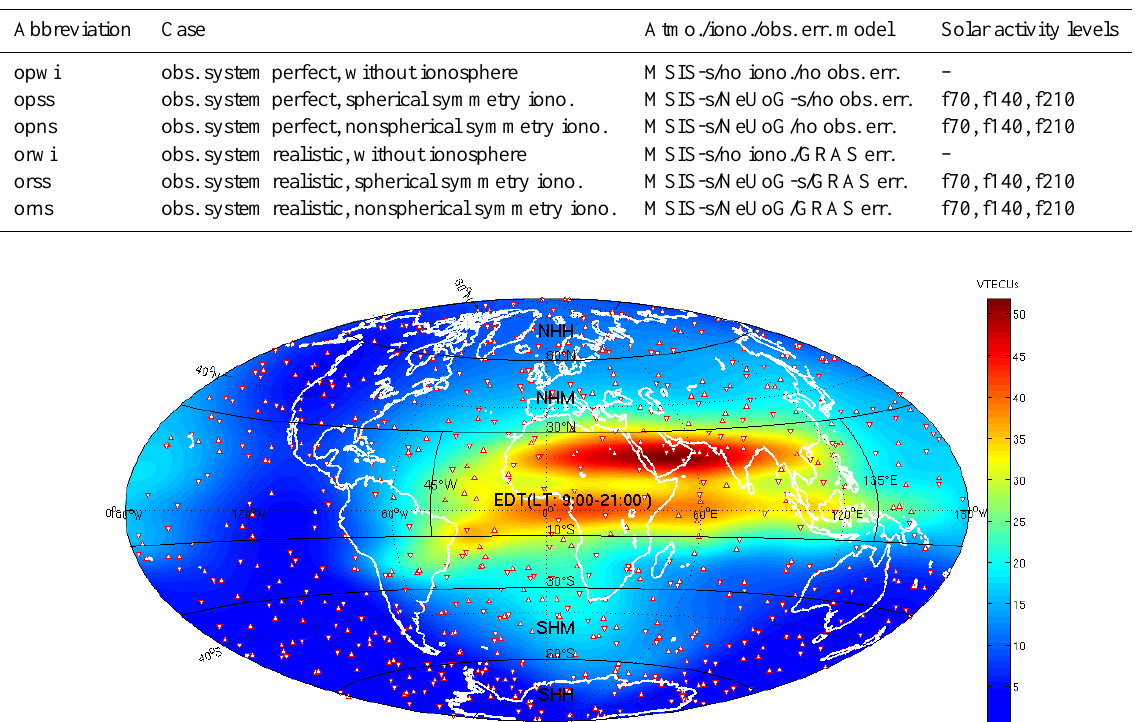
Table 2. Definition of end-to-end simulation cases for various ionospheric conditions and solar activity levels under the assumptions of no observing system errors or realistic observing system errors.